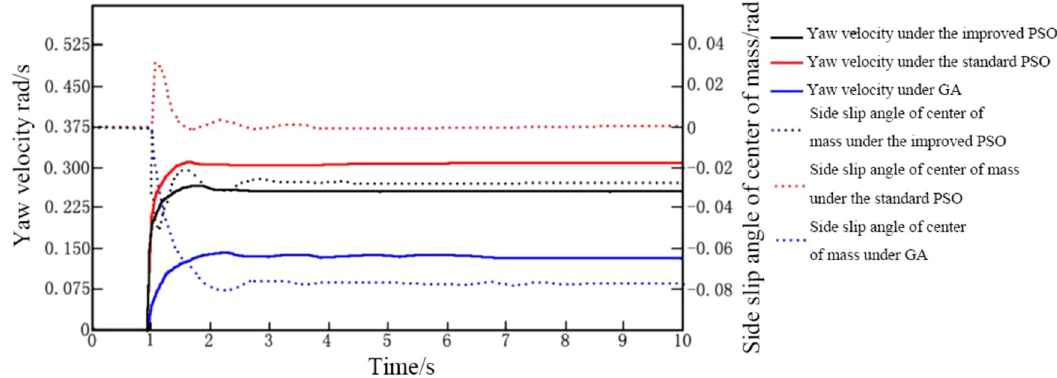
Fig. 7. Changes of the yaw velocity and side slip angle of the center of mass of the forklift in the high-speed